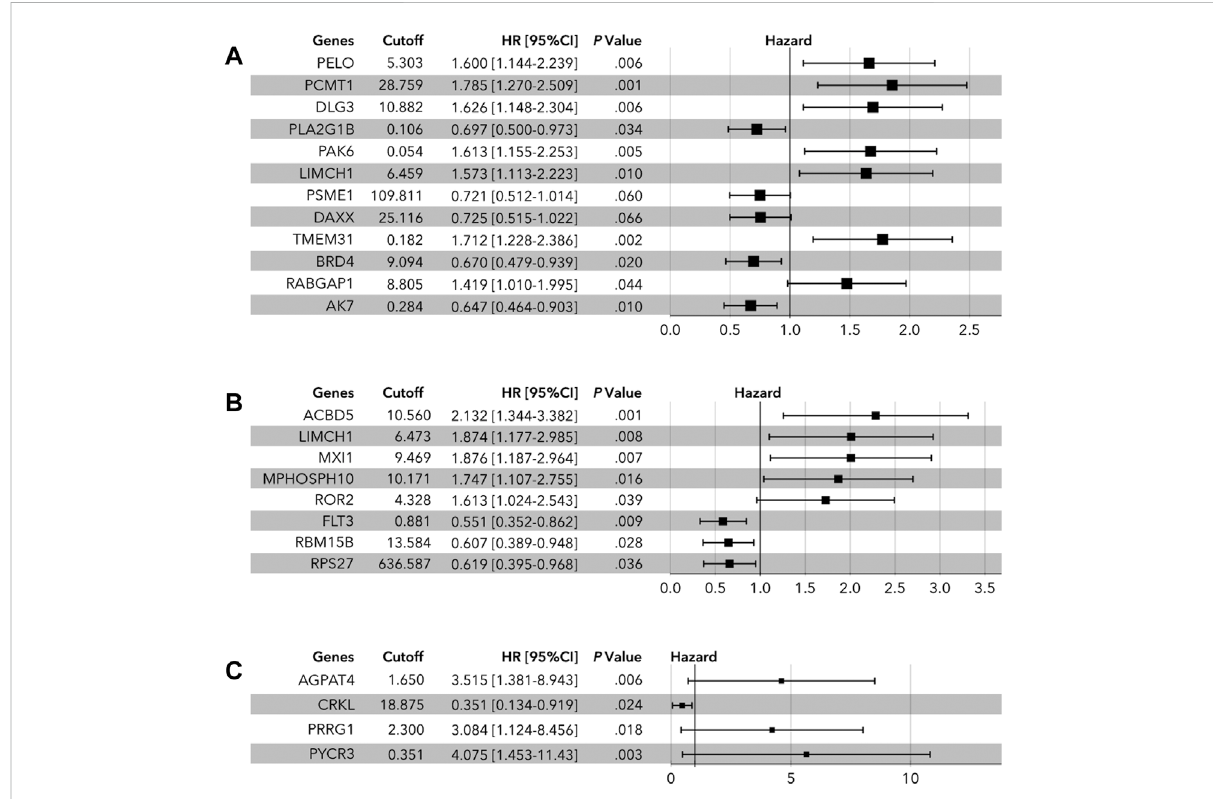
FIGURE 2 Multivariate Cox regression analysis of LLPS-related genes. (A) In all cohort, PELO, PCMT1, DLG3, PLA2G1B, PAK6, LIMCH1, PSME1, DAXX, TMEM31, BRD4, RABGAP1, and AK7 were identi fi ed to determine the risk-score. (B) In the luminal cohort, ACBD5, LIMCH1, MXI1, MPHOSPH10, ROR2, FLT3, RBM15B, and ROS27 were identi fi ed to determine the risk-score. (C) In the TNBC cohort, AGPAT4, CRKL, PRRG1, and PYCR3 were identi fi ed to calculate the